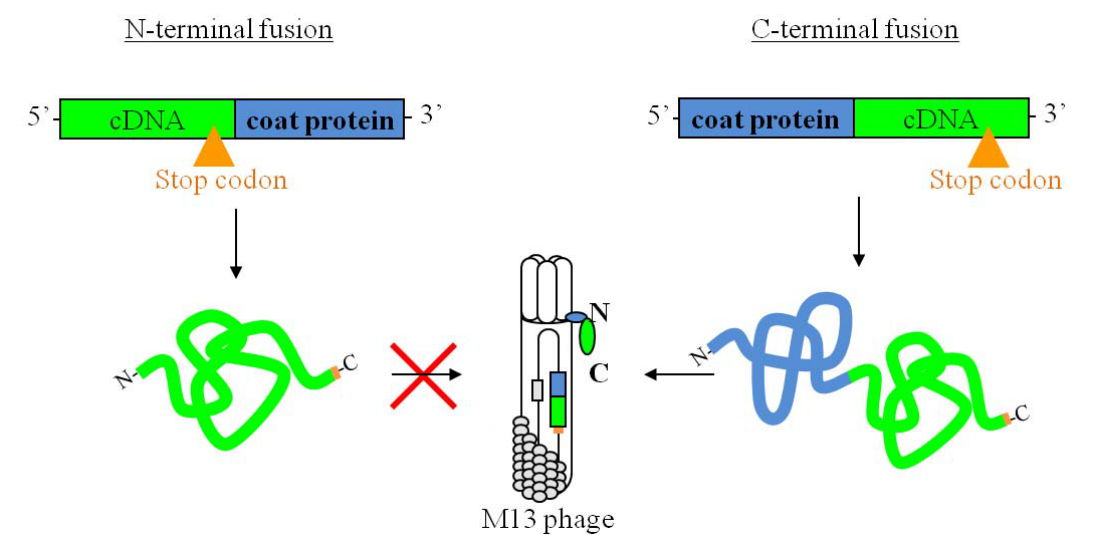
Figure 1. N- and C-terminal fusion of cDNA to a phage coat